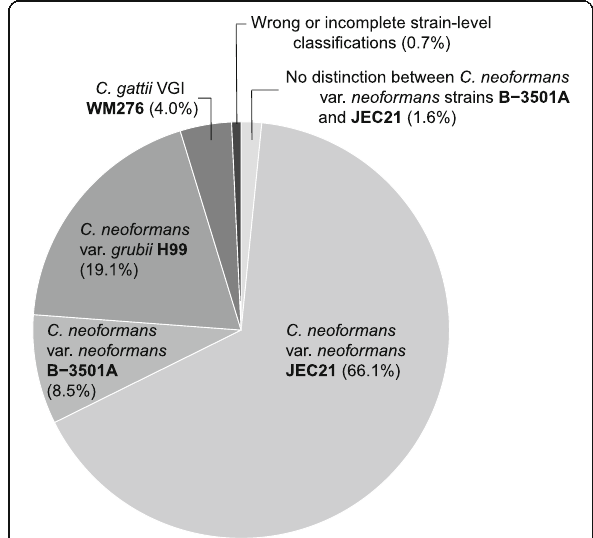
Fig. 2 Strain-level classifications of taxa within the Cryptococcus neoformans and C. gattii species